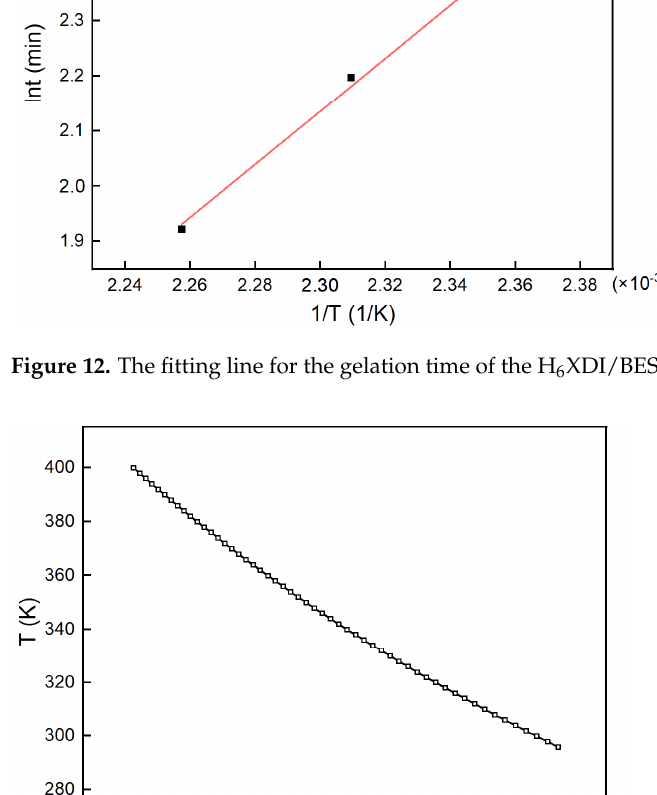
Figure 13. Gelation curve of the H 6 XDI/BES system.